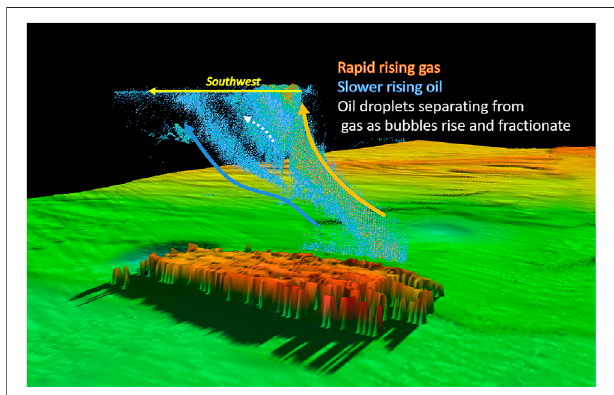
FIGURE 6 | Three-dimensional model of the oil and gas plume on 2 September 2018: Relative backscatter intensity from the M3 multibeam is scaled as blue – orange: low – high. Arrows de fi ne the components of the plume. See text for explanation, original Fig. 3.16 (Mason et al.,